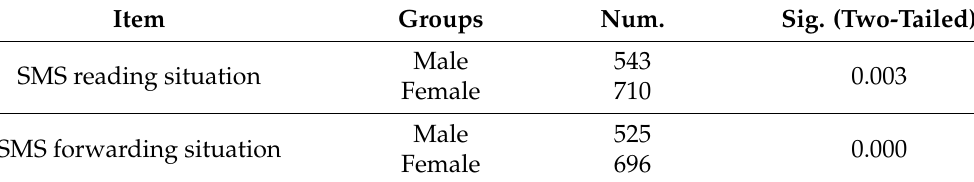
Table 6. Reading and forwarding situations between males and females.